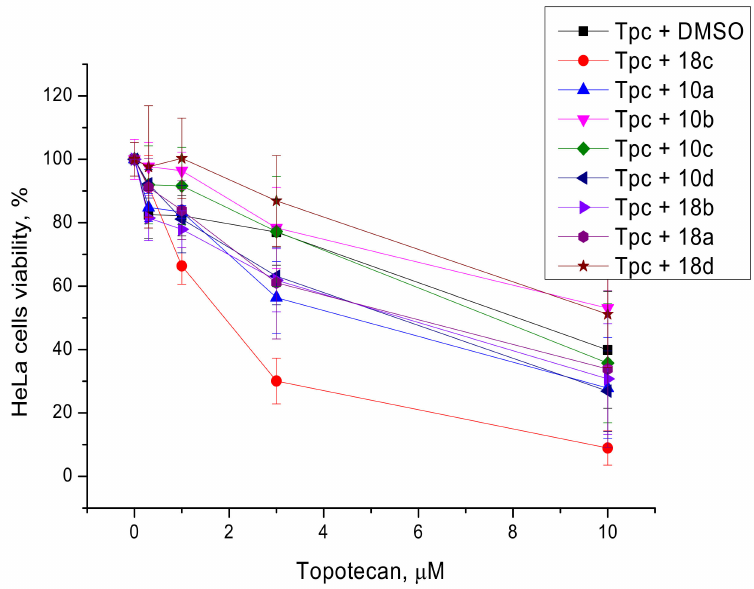
Figure 9. The influence of the berberrubine sultones at 20 µ M on topotecan cytotoxicity. Error bars show standard